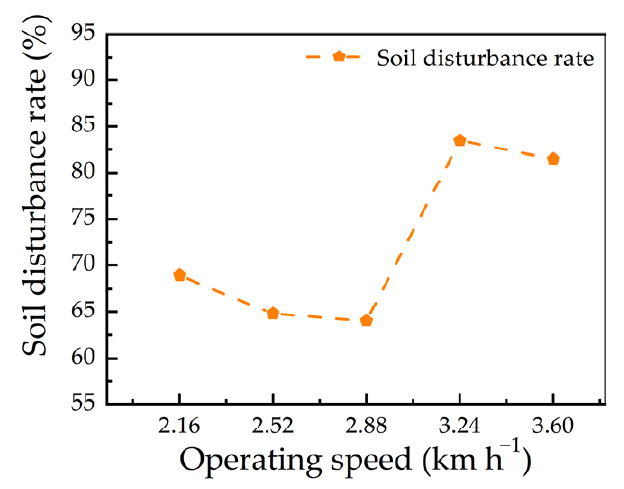
Figure 9. Effect of the operating speed on Soil disturbance rate. Soil Backfilling Rate at Different Speeds When the furrow opener is fully buried during operation, the soil is disturbed mainly